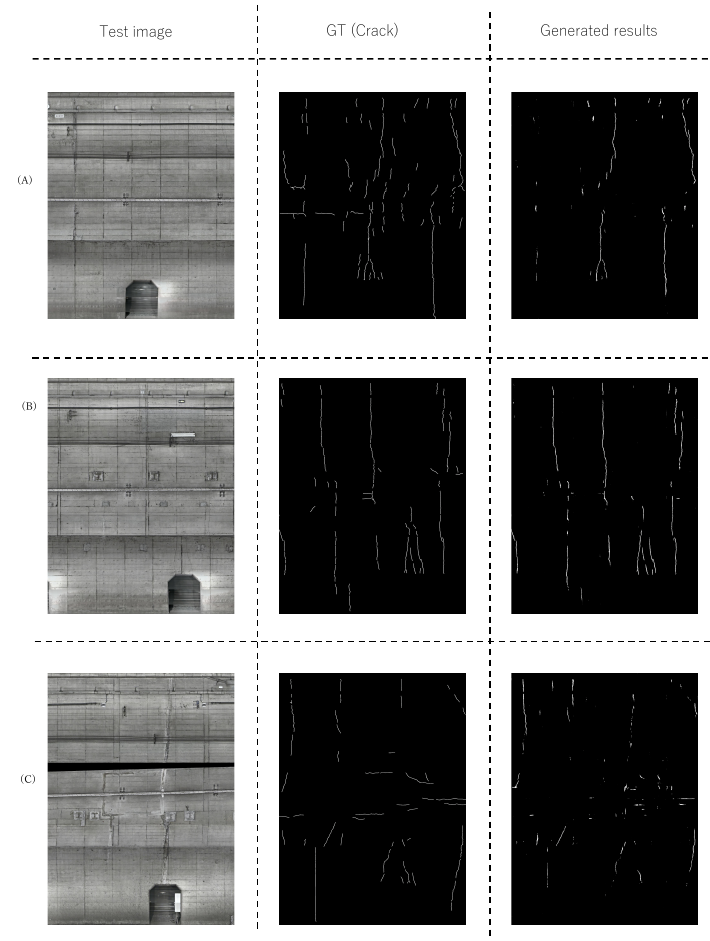
Figure 8. Examples of the results of the proposed method in the ablation study. Figures ( A – C ) represent each test